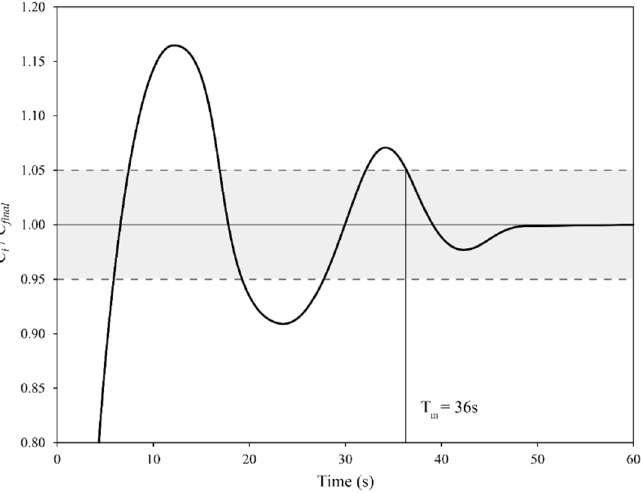
Figure 1. Graphical example of how mixing time can be calculated given the ratio C i /C final over time.